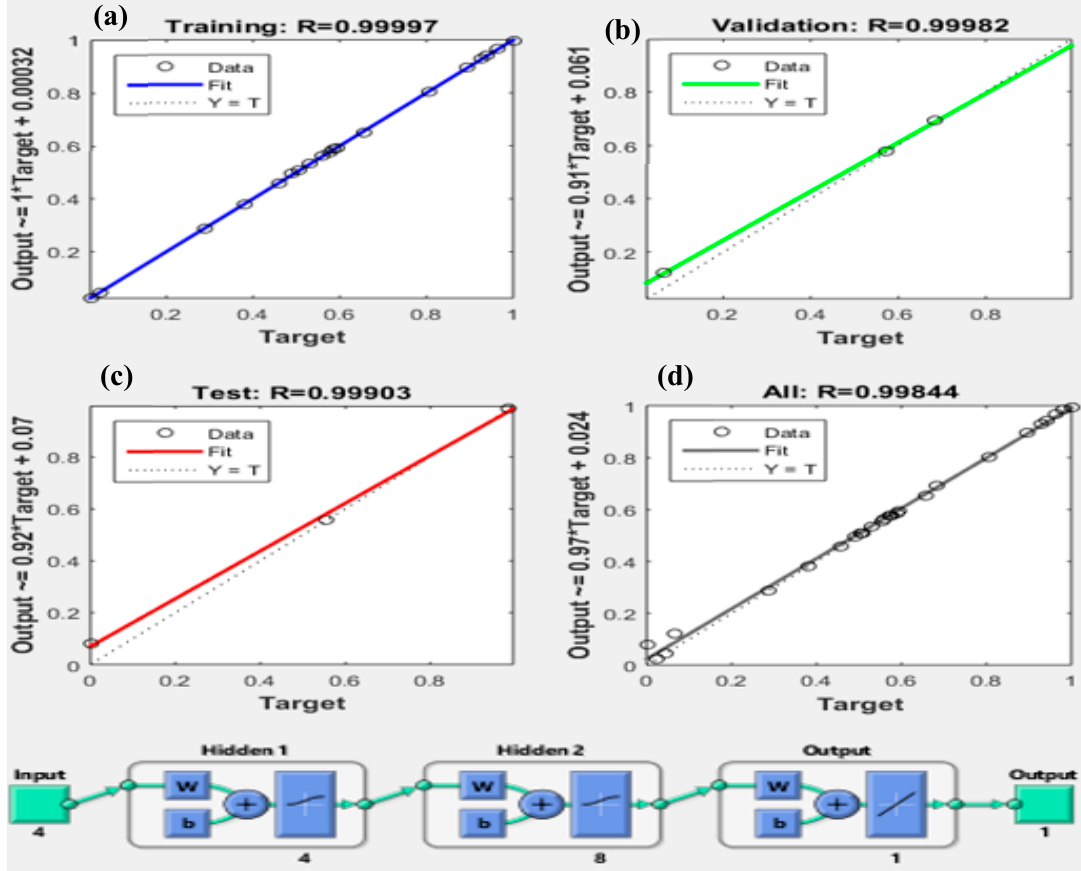
Figure 6. Artificial neural network model coe ffi cient of determination and error relationship of data set of fluorescent carbon dots. ( a ) Trained R 2 output, ( b ) Validated R 2 output, ( c ) Test R 2 output, and ( d ) Overall R 2 output of data